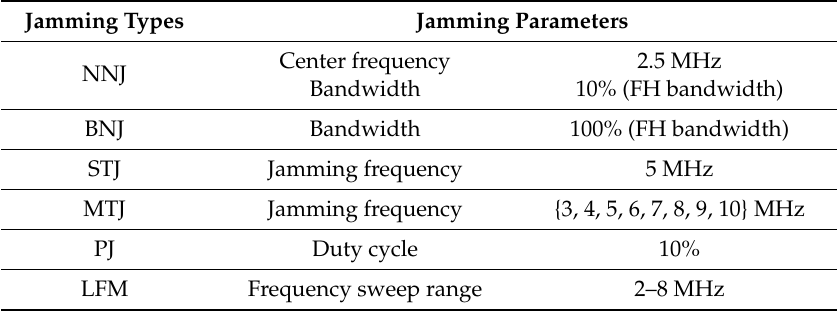
Table 1. Jamming signal